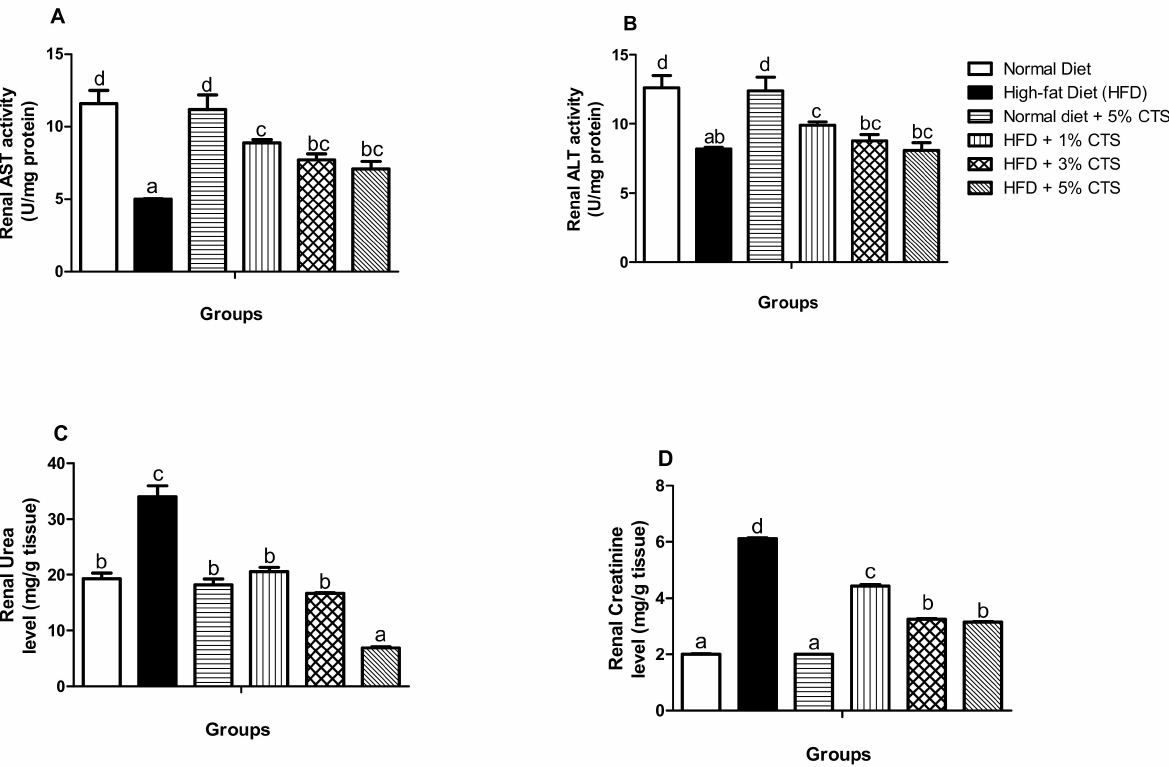
Figure 1. Effects of chitosan supplementation on renal biomarkers of High-fat diet (HFD)-fed rats. Values are expressed as mean ± SEM ( n = 5). Bars with distinct letters are statistically ( p < 0.05) different. a–renal AST activity; b–renal ALT activity; c–enal urea level; d–renal creatinine. AST–Aspartate aminotransferase; ALT–Alanine aminotransferase;